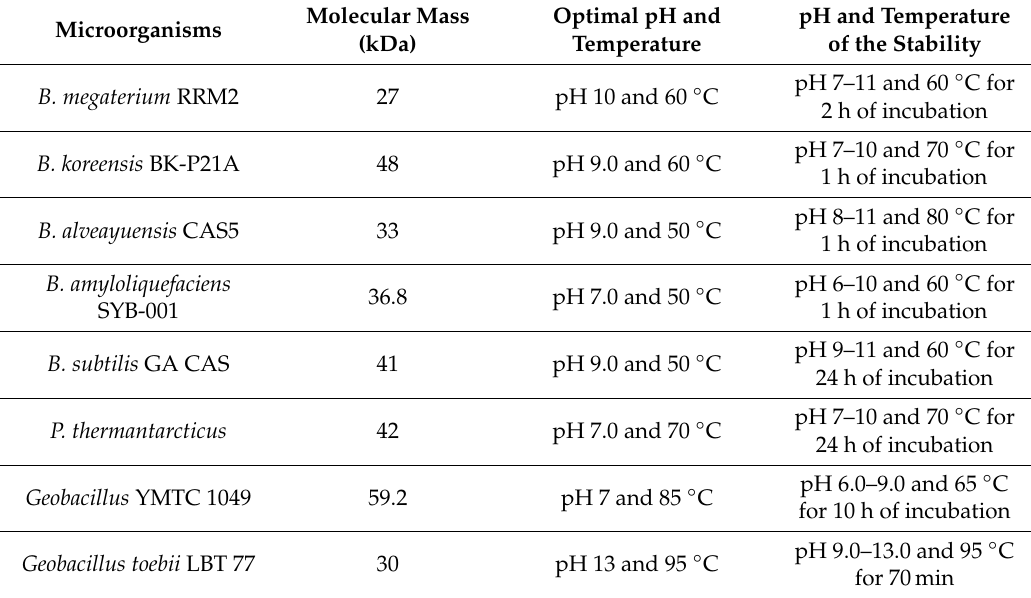
Table 3. Characteristics of some Bacillus and Geobacillus proteases in comparison with P. thermantarcticus